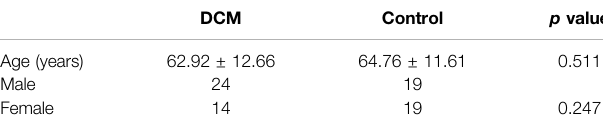
TABLE 1 | Patient